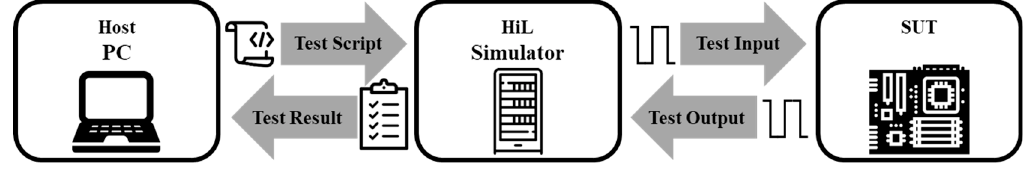
Figure 2. Hardware-in-the-loop (HiL) test environment.